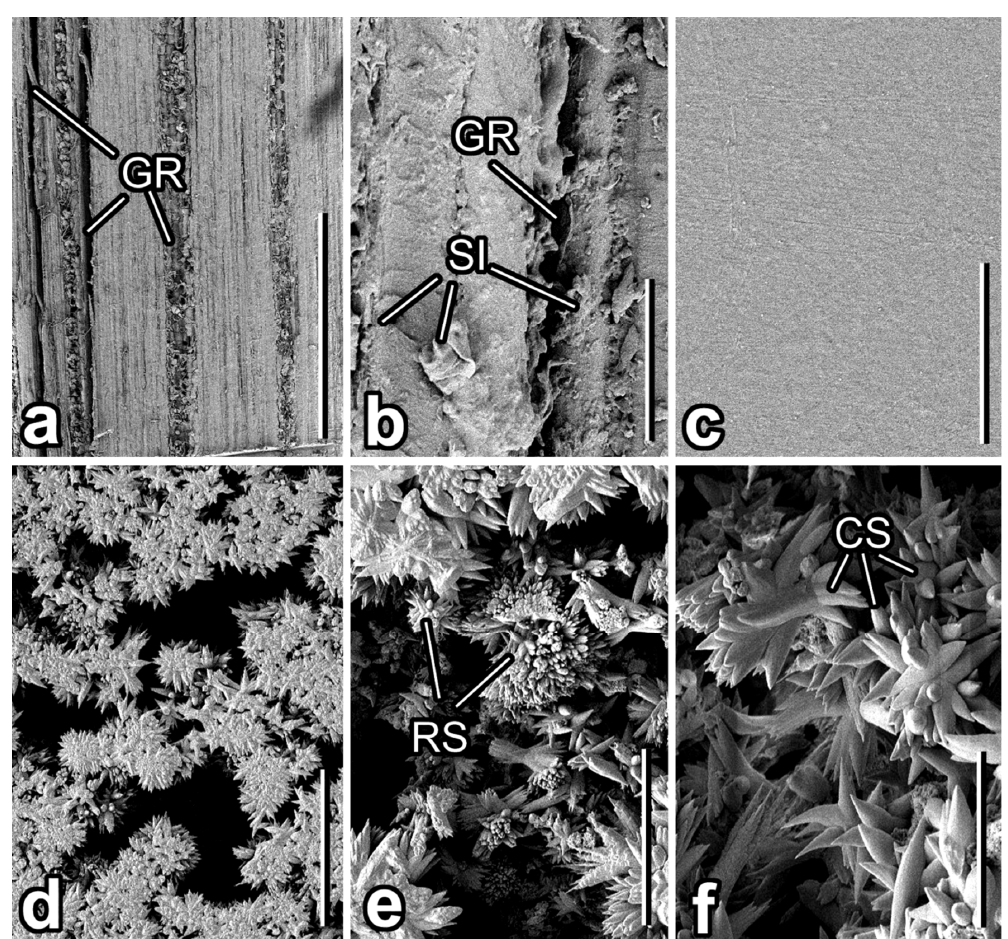
Figure 4. Surfaces of different experimental samples (SEM). ( a,b ) Intact stick. ( c ) Transparent polyester film. ( d – f ) Cal- cium carbonate (CaCO 3 ) coverage. Abbreviations: CS—cone-shaped structures; GR—grooves; RS—double rosettes; SI—surface irregularities. Scale bars: 1 mm ( a ), 20 μ m ( d ), 10 μ m ( b , e ), 5 μ m ( c , f ).